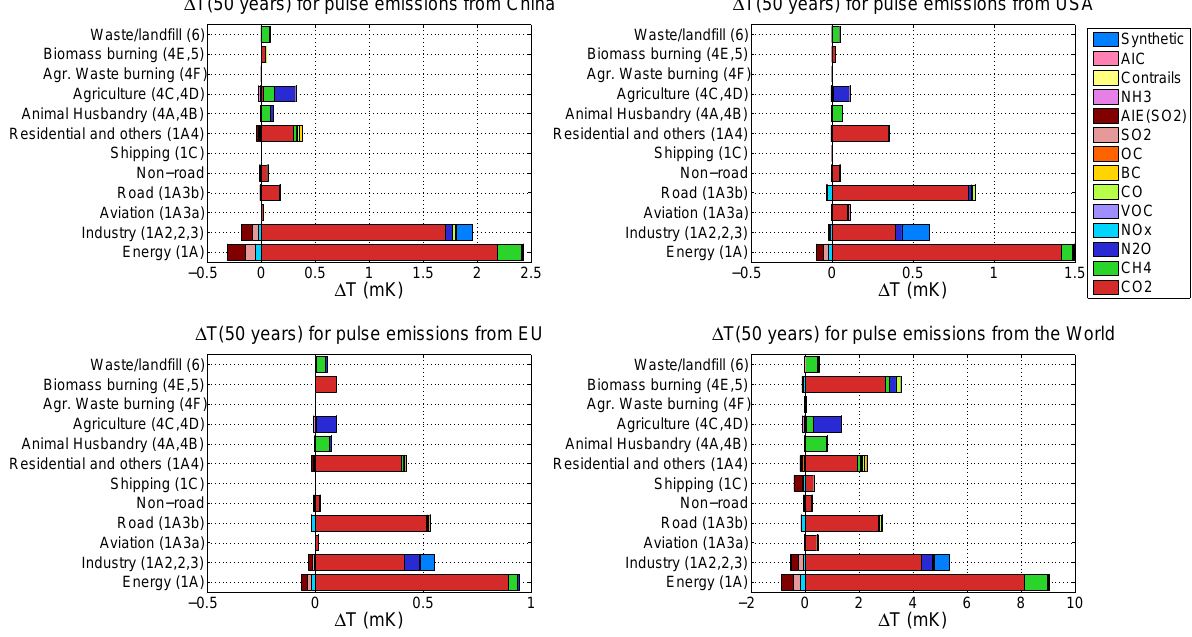
Fig. 12. The estimated temperature perturbation based on AGTP 50yr after EDGAR 2008 emission for different sectors. For a shorter time horizon, the non-CO 2 effects will be relative larger compared to CO 2 . “Synthetic” represents the mainly halogenated hydrocarbons in the Kyoto and Montreal Protocols. BC and OC emissions from biomass burning are not